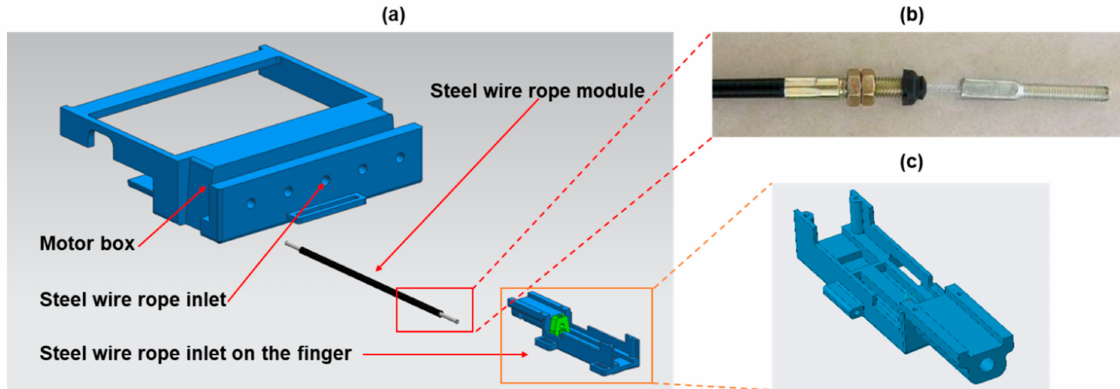
Figure 3. Transmission mechanism ( a ) assembly drawing, ( b ) Bowden cable module, and ( c ) connecting